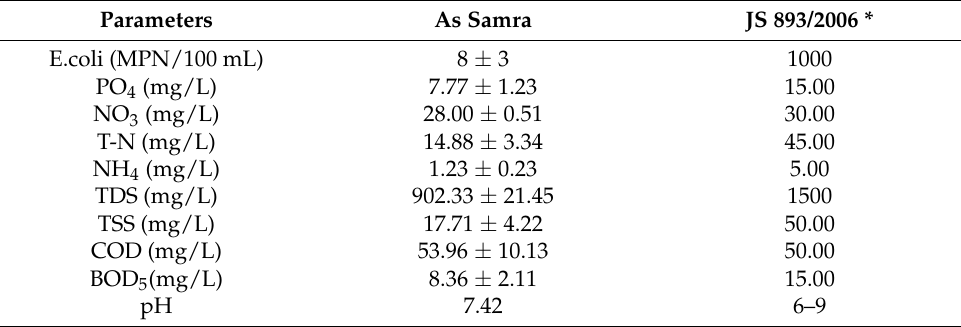
Table 2. Effluent water quality parameters from As-Samra